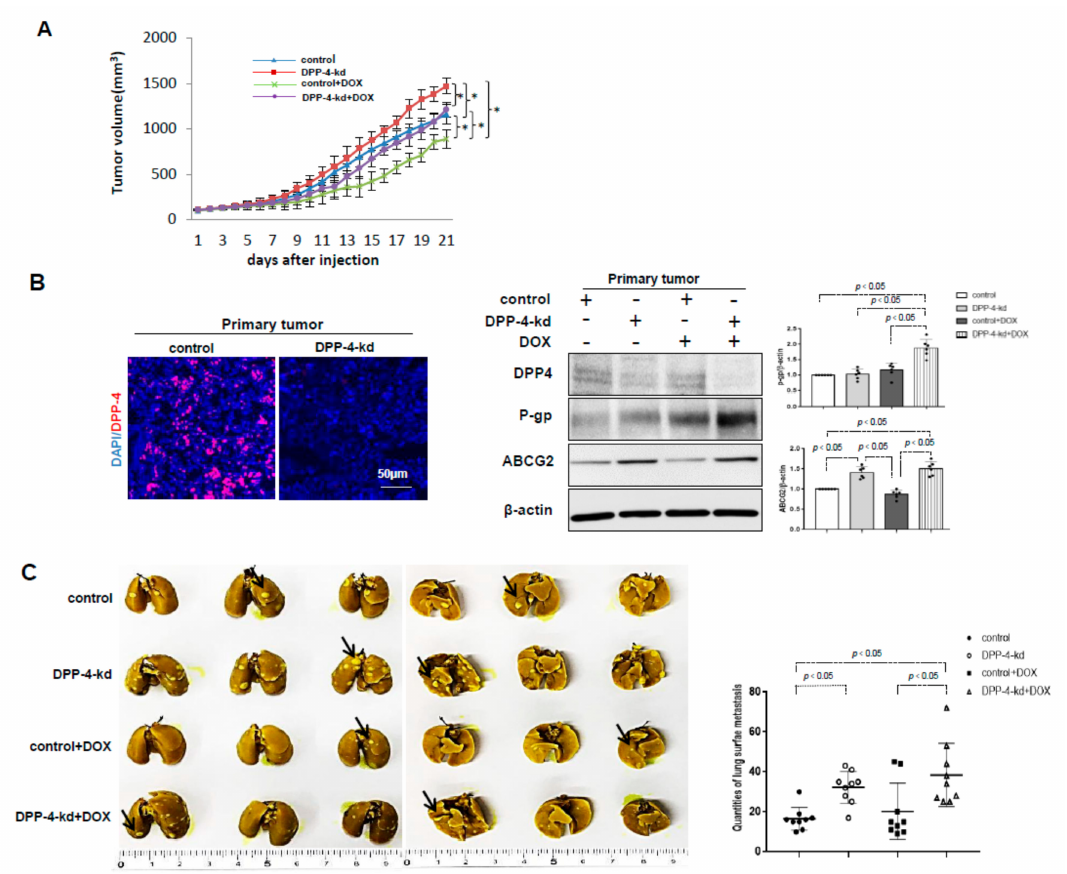
Figure 5. The influence of DPP-4 knockdown on promoting primary tumor growth, metastasis and chemoresistance in vivo. Eight-week-old female BALB / c mice were orthotopically implanted with DPP-4 shRNA knockdown (DPP-4-kd) and shRNA-control (control) 4T1 cells into mammary fat pads of each mouse. Concomitantly, the mice were randomly allocated to one of the following four groups: (1) control; (2) DPP-4-kd; (3) control + DOX and (4) DPP-4-kd + DOX groups. When the tumor volumes reached 80–100 mm 3 , mice were intraperitoneally injected with DOX (5 mg / kg, once a week). Twenty-one days after treatment, the mice were sacrificed, and the primary tumors and lungs were analyzed. ( A ) The tumor volume in each group was measured ever day during treatment (* p < 0.05). ( B ) Immunofluorescence analysis of DPP-4 expression in control and DPP-4-kd primary tumors. Western blot analysis of P-gp and ABCG2 expressions in the primary tumor tissue. Densitometric analysis of protein expression relative to β -actin levels ( n = 6 per group) was performed by using ImageJ. ( C ) The lung surface metastases (left panel) were imaged, and the quantification of lung metastases (right panel) was performed by Bouin staining. Black arrows indicated lung surface metastases. The data in the graphs was shown as mean ± SEM; n =